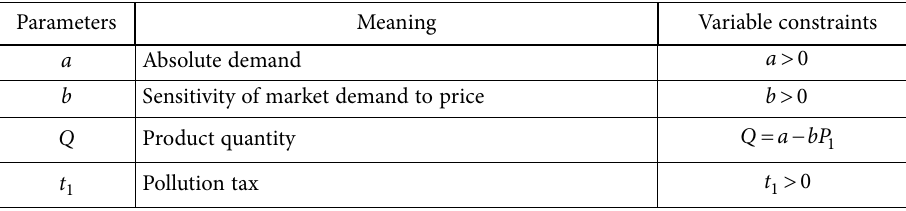
Table 3. Other parameters and basic quantitative relations